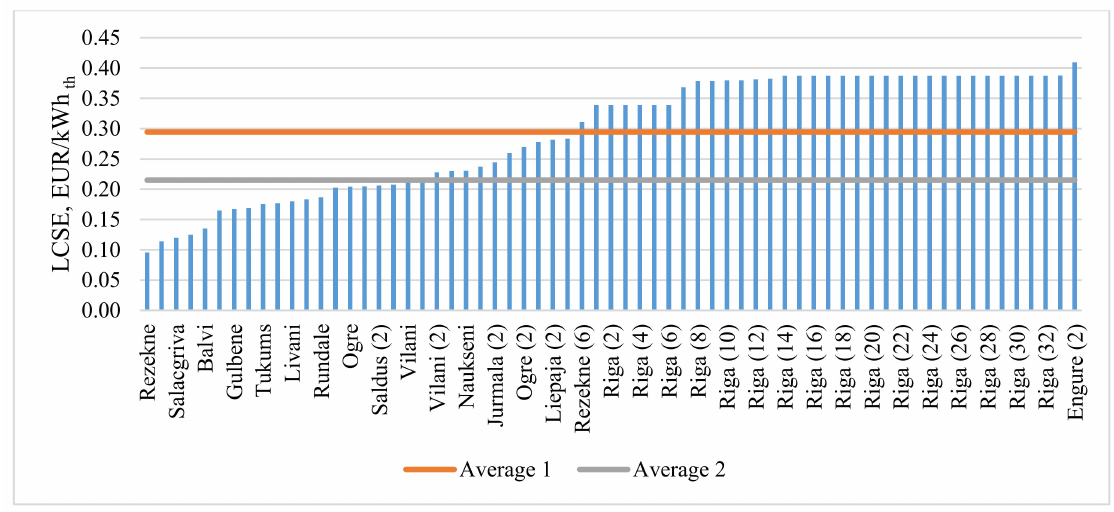
Figure 9. Overview of identified specific costs of energy savings in di ff erent Municipalities in case of Program